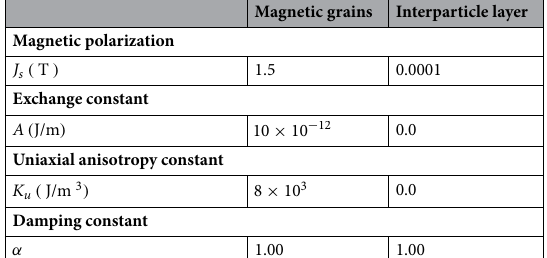
Magnetic grains Interparticle